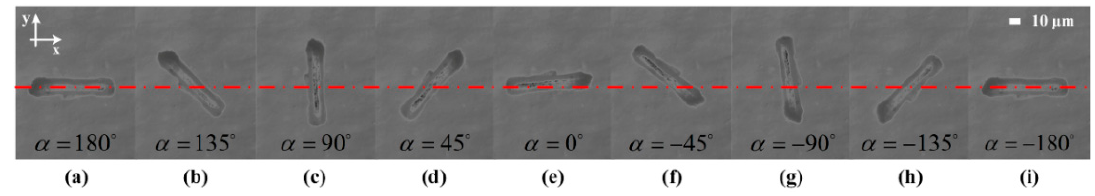
Figure 8. The clockwise rotation of the silica rod lying on the agar from 180 ◦ to − 180 ◦ ( a – i ) with 45 ◦ interval. Appl. Sci. 2018 , 8 , 73 Figure 9. Rotation from 180° to 0° ( a ) and 0° to − 180° ( b ).